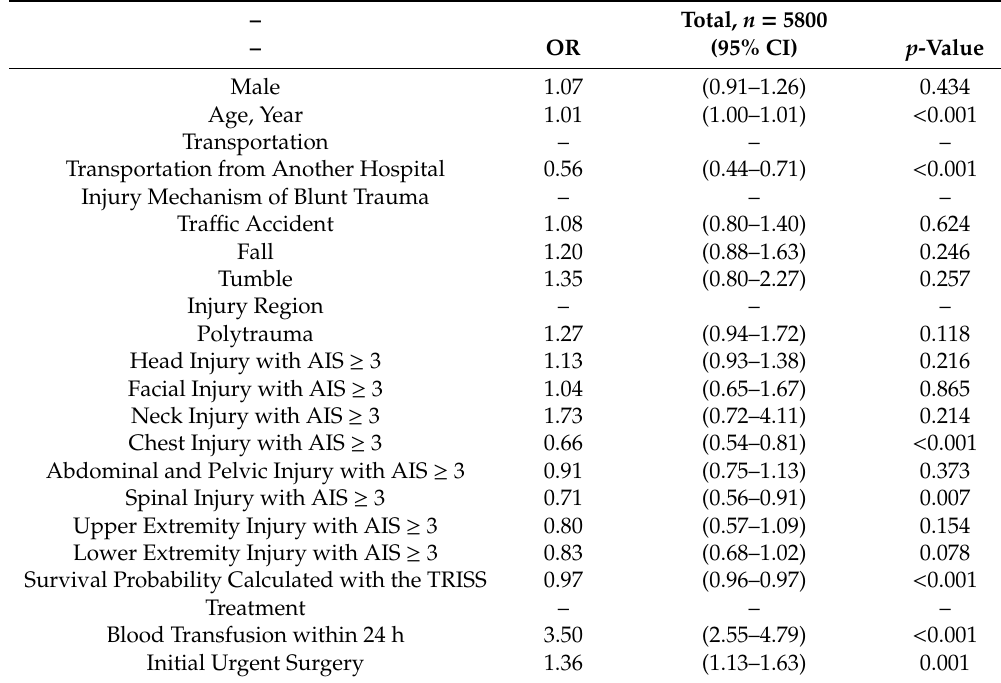
Table 3. Multivariate logistic regression analysis of in-hospital mortality among trauma patients who underwent transcatheter arterial